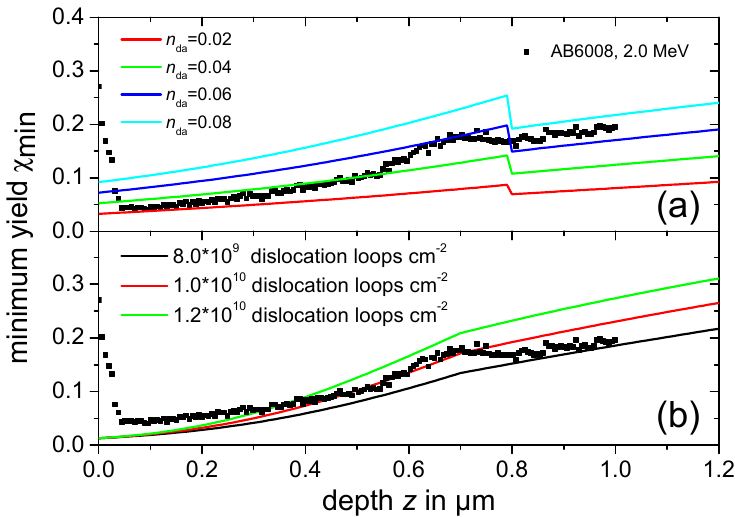
Figure 5. Minimum yield χ min versus depth z for sample AB6008 (ZnO:Al deposited with 13.56 MHz) measured with He ions of 2.0 MeV energy (symbols). The impact of the different type and number of defects on the χ min spectra are demonstrated by DICADA1 calculations (solid lines), ( a ) shows the impact of point defects represented by randomly distributed displaced lattice atoms with various relative concentrations n da . In ( b ), spectra are depicted assuming dislocation loops of various areal concentrations. For details see text.